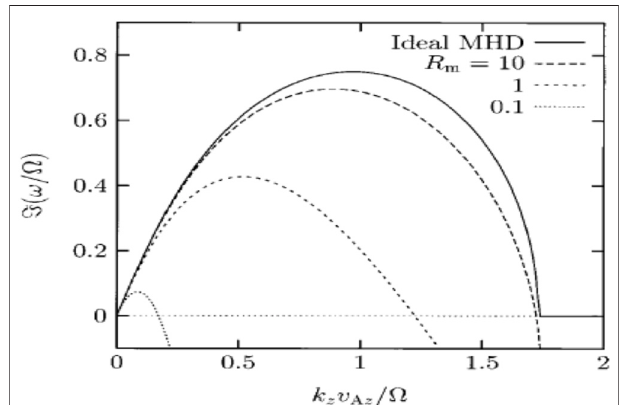
FIGURE 13 | Surface plot of the MRi growth rate in the compressible case in the k r − k z plane with R m (cid:1) 1 and a particular set of parameters. Adapted fromSanoand